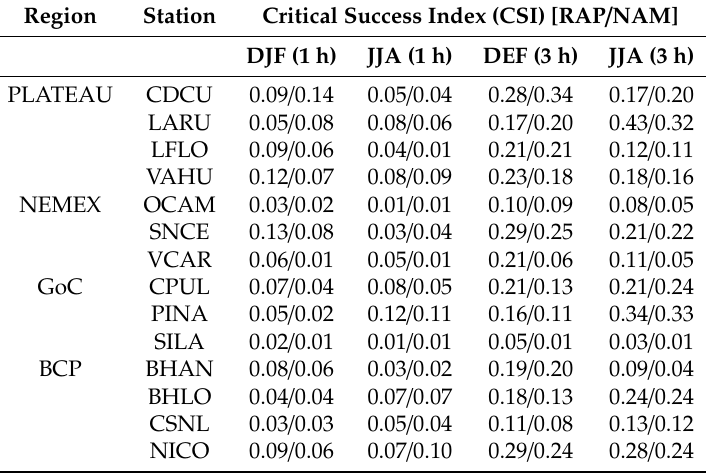
Table 4. 2013 Critical Success Index (CSI) for wind power ramps in RAP and NAM models during December–January–February (DJF) and June–July–August (JJA) 2013. Ramps are power changes of 20% of rated power in 1 h or 3